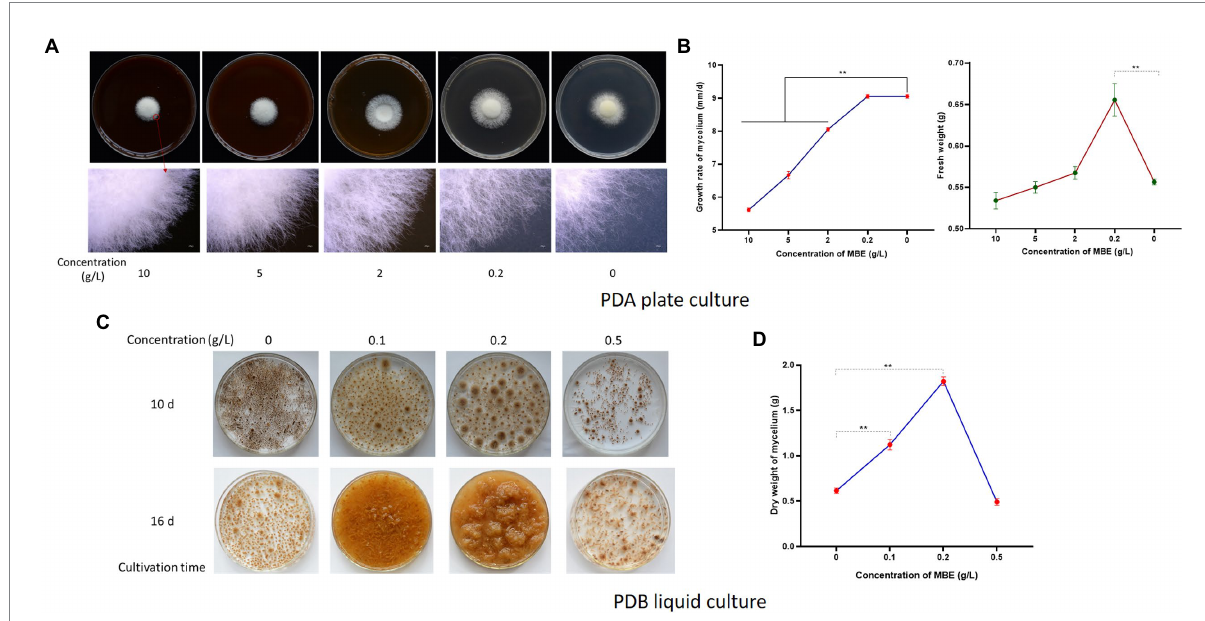
FIGURE 1 Effects of mulberry branch extracts (MBE) on Sanghuangprous vaninii mycelium. (A) Effects of different concentrations of MBE on the growth of S. vaninii mycelium on plate after 7 days of cultivation. The upper figures are the outline of the colony, and the lower figures are the 20× edge of colony. (B) Statistics of growth rate and fresh weight of S. vaninii mycelium on plate. (C) Effect of different concentrations of MBE on the growth of S. vaninii mycelium in liquid culture. (D) Statistics of dry weight of S. vaninii mycelium after 16 days of liquid cultivation. Three biological replicates were analyzed. Data are shown as means ± SEM. ** p <